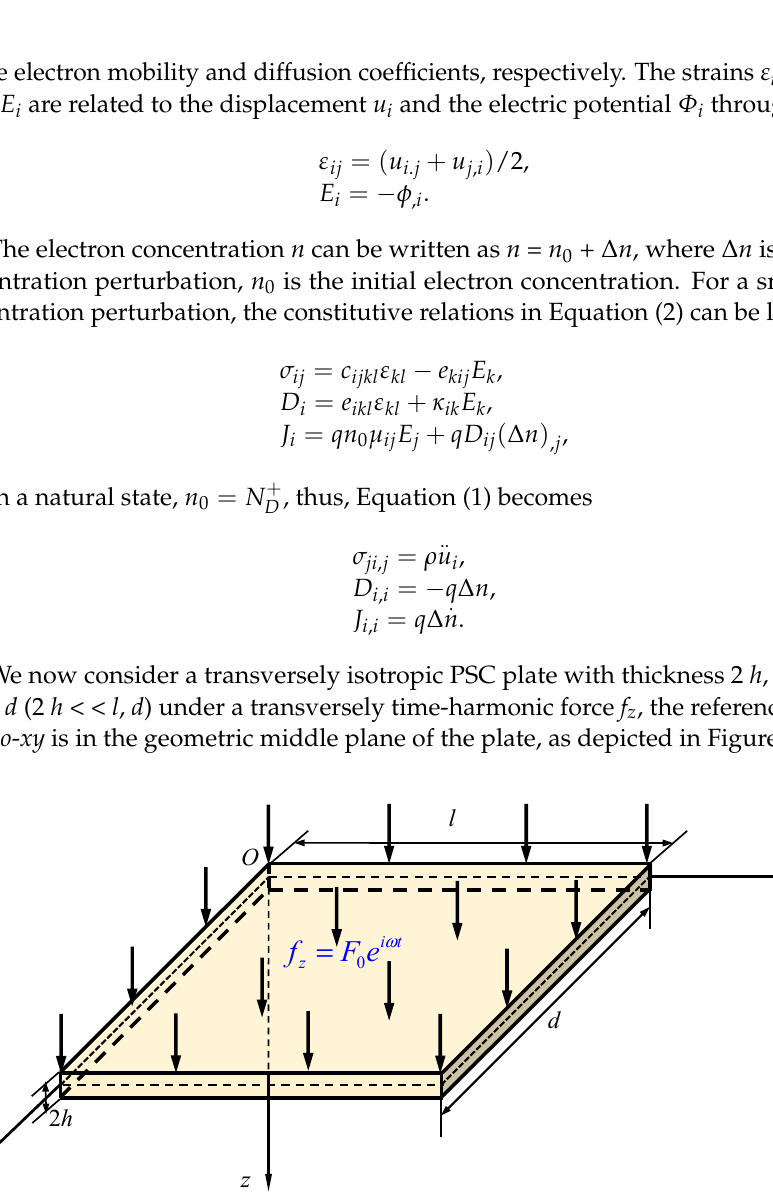
Figure 1. A PSC plate subjected to a transverse time-harmonic force f z .